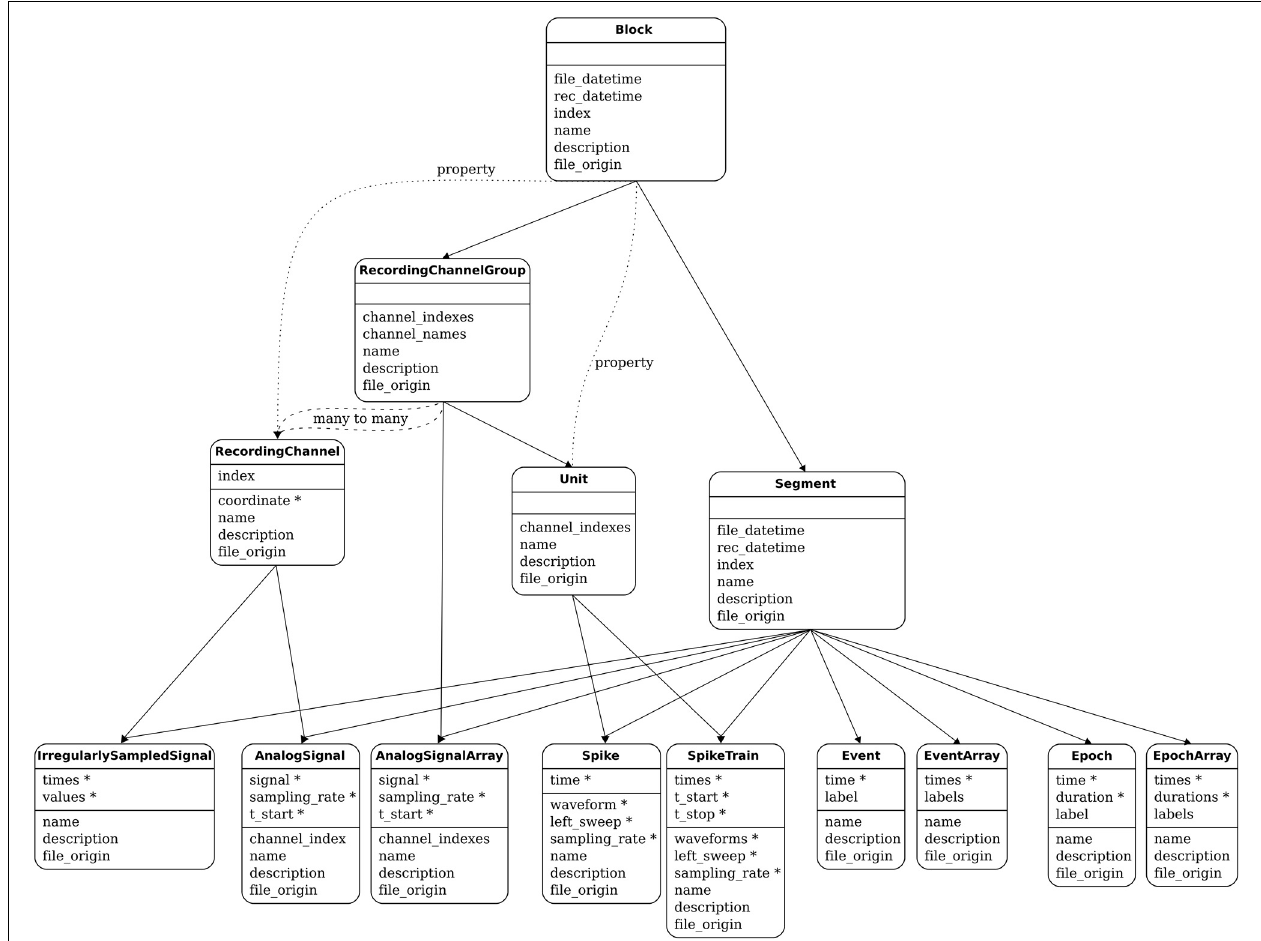
FIGURE 2 | The Neo object model: the principal classes and their relationships. For each class, a horizontal line separates the required attributes from the suggested attributes. The stars mark the attributes that have an associated